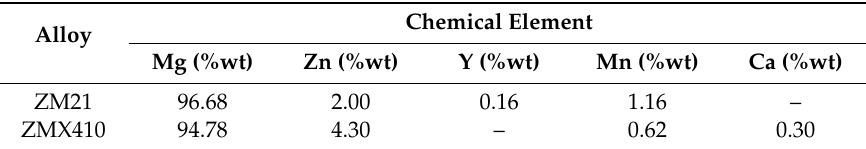
Table 1. Chemical composition of experimental Mg